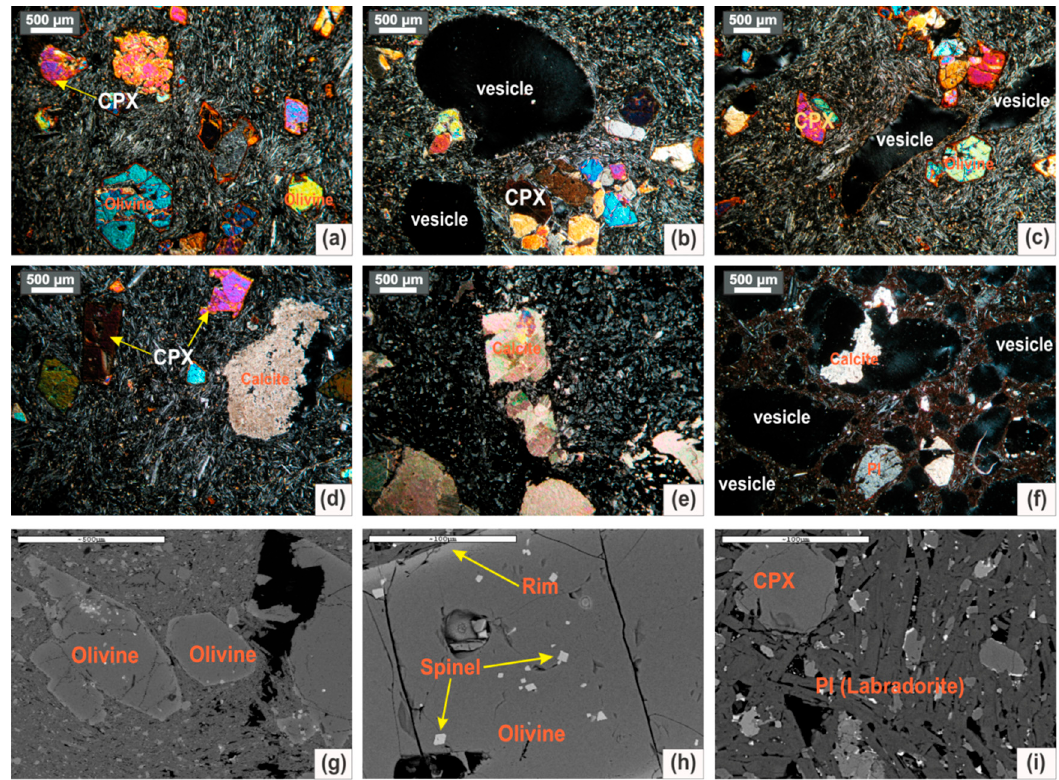
Figure 2. ( a ) Olivine and clinopyroxene phenocrystals in a hypo ‐ crystalline trachytic groundmass mostly consisting of lath ‐ shaped plagioclase but also K ‐ felspar (Sample M3). ( b , c ) Vesicular basaltic lava samples M1 and M8, mainly consisting of clinopyroxene and also olivine phenocrystals, exhibiting glomeroporphyritic textures. It includes a hypo ‐ crystalline trachytic groundmass, as well as vesicular textures. ( d ) Vesicular basaltic lava sample M2, with clinopyroxene and olivine phenocrystals in a trachytic groundmass. Vesicles are occasionally filled with secondary calcite ‐ forming amygdaloidal textures. ( e ) Vesicular basaltic lava sample M5, within a microcrystalline vesicular groundmass, filled with secondary calcite. ( f ) Pyroclastic tuff with a high percentage of vesicles. Groundmass locally aphanitic with rare feldspar phenocrysts. ( g – i ) BSE (Back Scattered Electron) images with olivine and clinopyroxene phenocrysts.